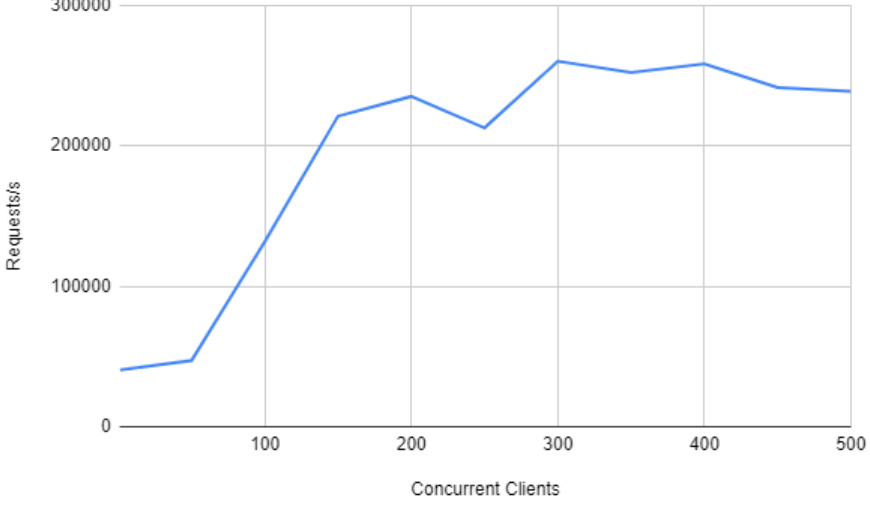
Figure 15. Mosquitto